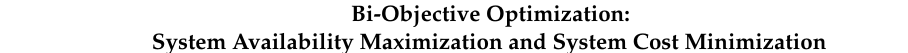
Table 5. Optimal design configurations for bi-objective optimization (first problem).